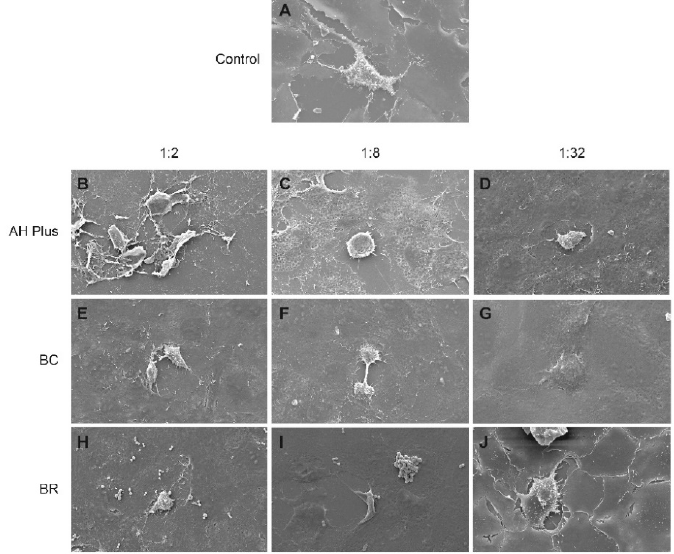
Figure 2. Scanning electron micrographs of the morphology of hMSCs control ( A ) exposed to ( B , E , H ) 1:2, ( C , F , I ) 1:8, and ( D , G , J ) 1:32 ( B – D ) AH Plus, ( E – G ) Endosequence BC, and ( H – J ) BioRoot sealer extracts for 24 h (×1000). Scale bars = 10 μ m.